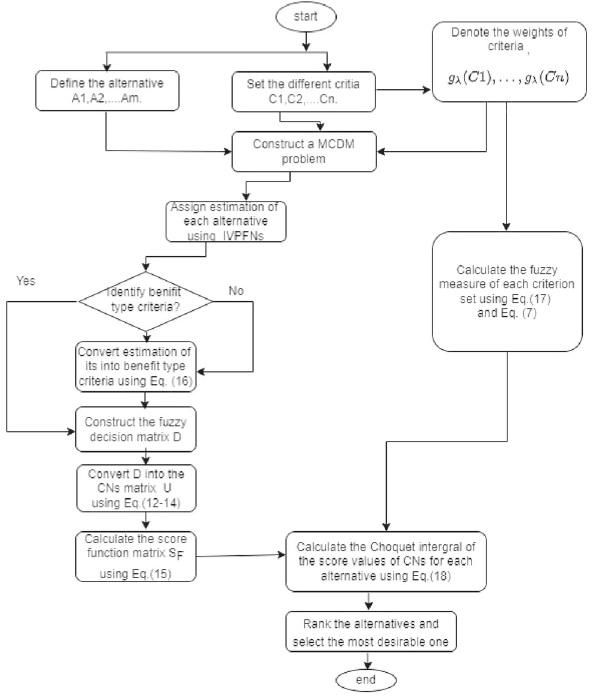
Fig. 1 Flow chart of the proposed